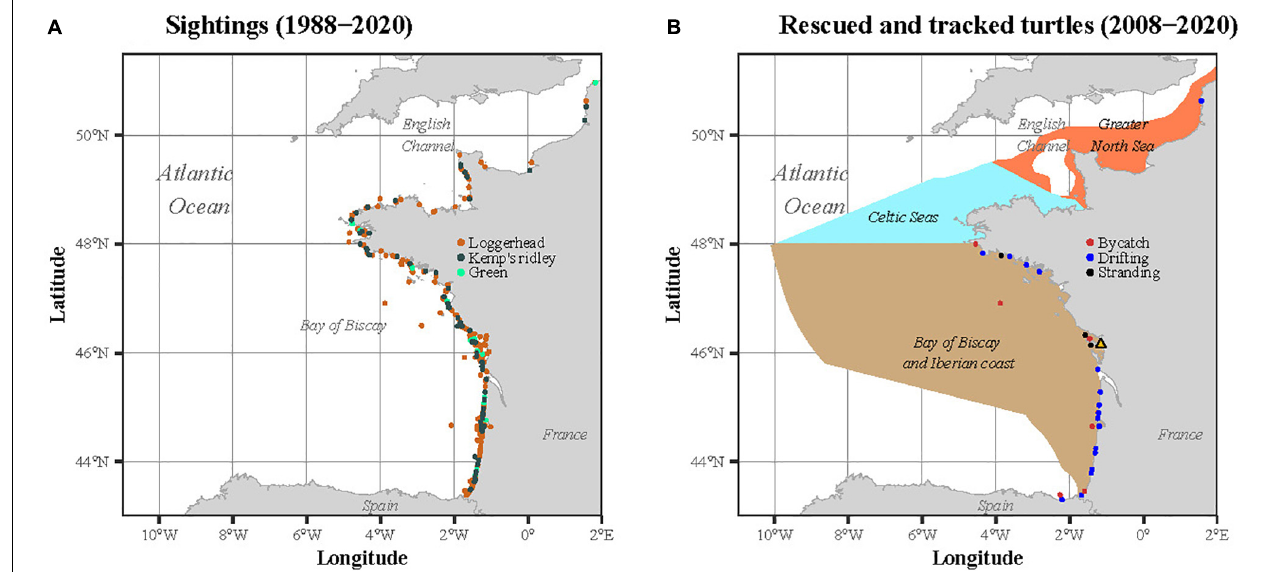
FIGURE 1 | Locations of (A) the sightings recorded between 1988 and 2020 and (B) the immature sea turtles rescued and satellite tracked by the CESTM between 2008 and 2020. In (B) , the three ecoregions as defined in the MSFD are represented in the background: the Greater North Sea, the Celtic Seas and the Bay of Biscay and Iberian